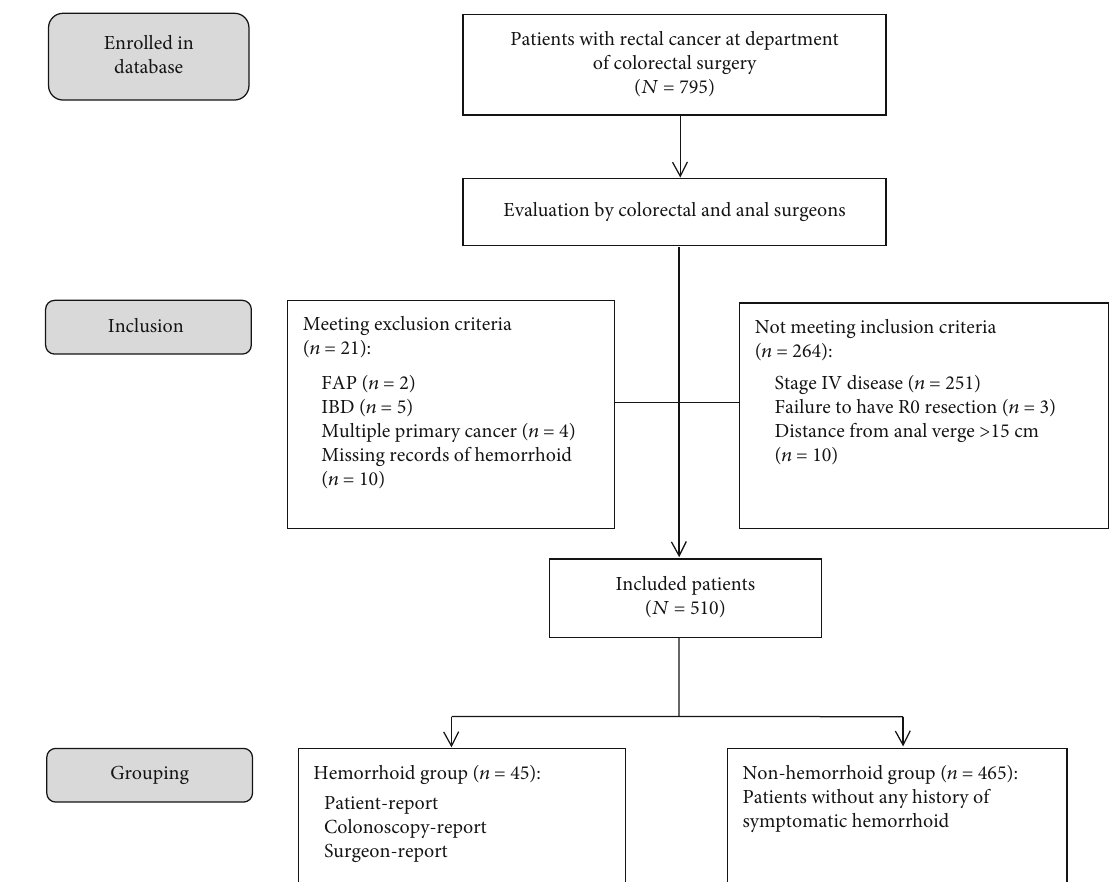
Figure 1: Flow diagram of patients disposition in the association analysis between hemorrhoid history and outcomes in rectal